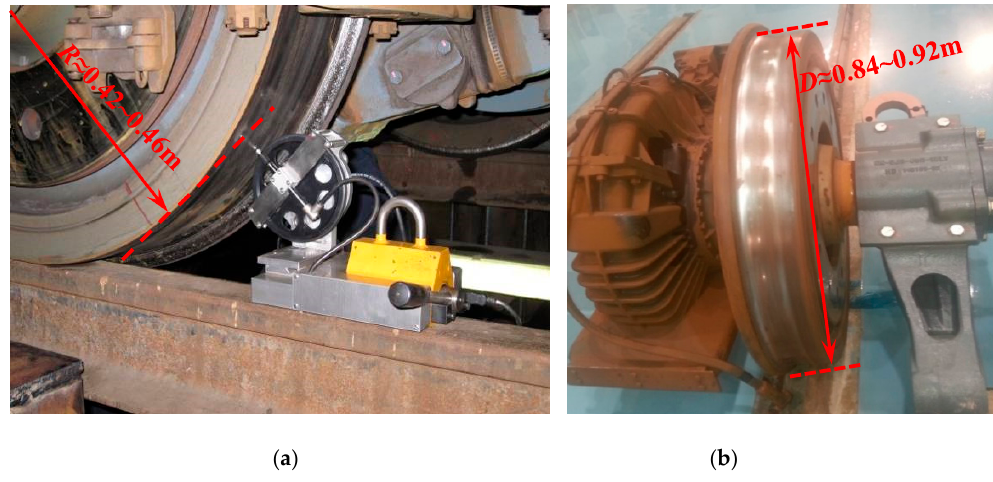
Figure 1. ( a ) Test instrument; ( b ) Polygonal wheel.